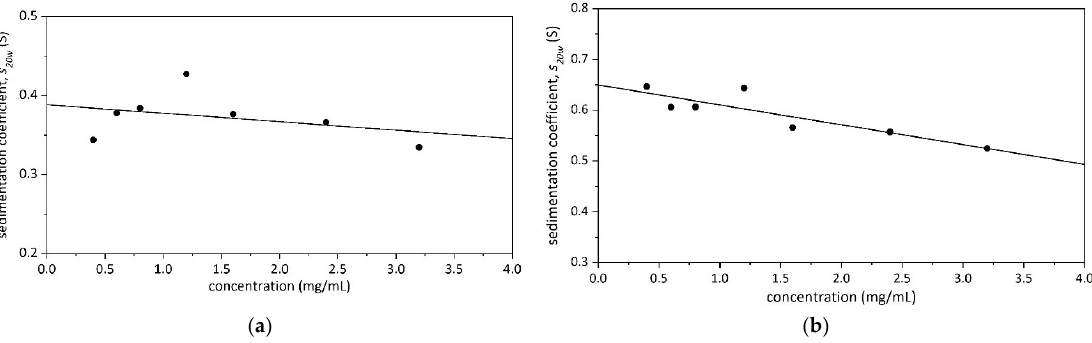
Figure 4. Dependence of s 20,w on sedimenting concentration (corrected for radial dilution) for Butvar B-98. ( a ) Slower component s o20,w = (0.40 ± 0.02) S; ( b ) Faster component s o20,w (0.65 ± 0.02) S. B-98. ( a ) Slower component s o 20,w = (0.40 ± 0.02) S; ( b ) Faster component s o 20,w (0.65 ± 0.02) S.